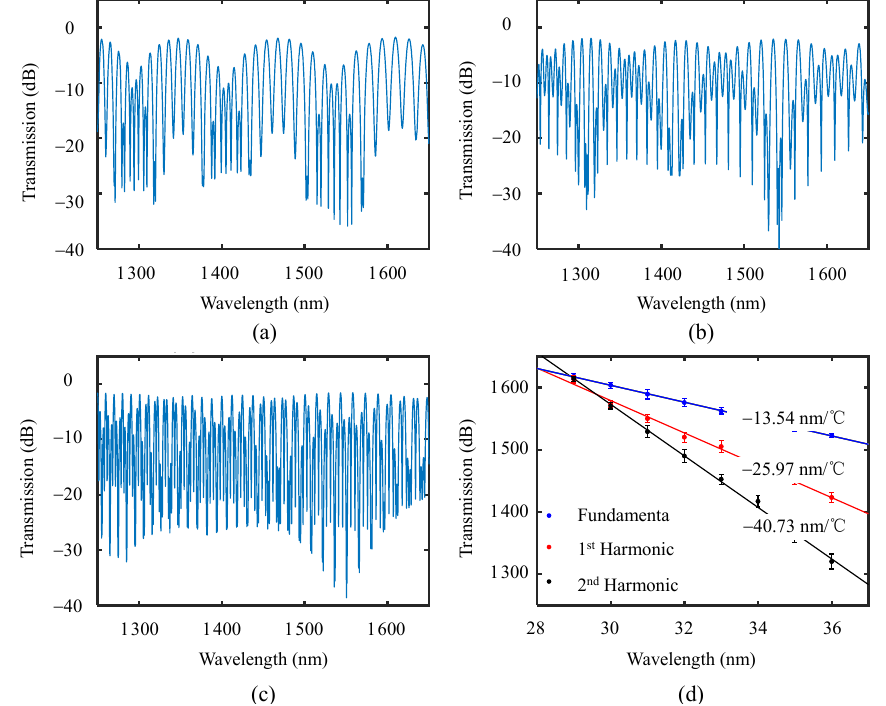
Fig. 7 Transmission spectra of (a) fundamental Vernier effect, (b) first-order Vernier effect, and (c) second-order Vernier effect, respectively; (d) corresponding temperature